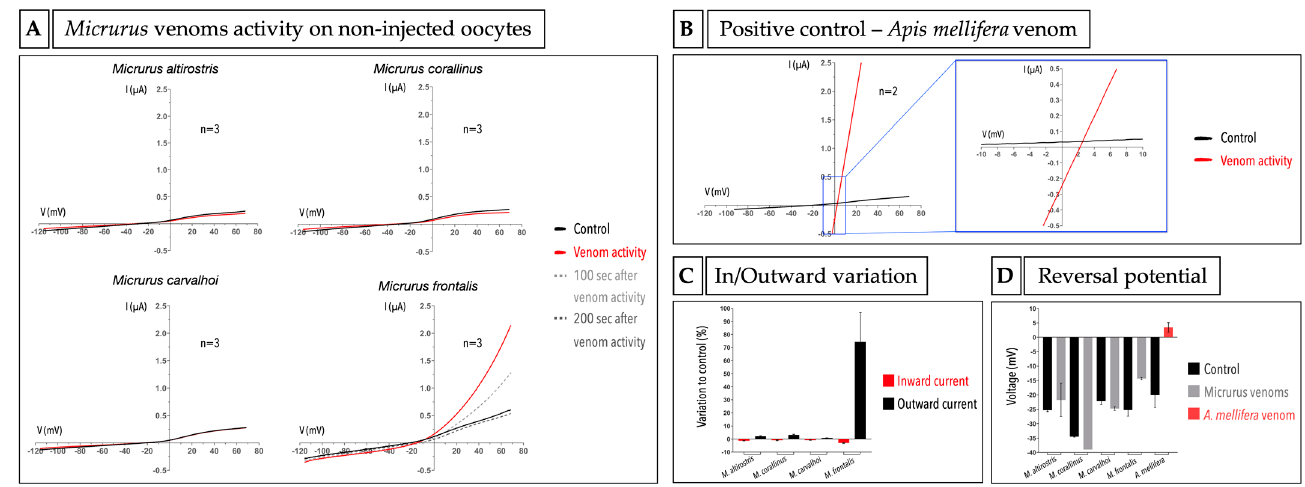
Figure 3. Cytotoxic evaluation of crude venoms on X. laevis non-injected oocytes. ( A ) Micrurus altirostris , Micrurus corallinus , Micrurus carvalhoi and Micrurus frontalis venom activity. ( B ) Positive control- Apis mellifera venom activity. The black lines show the control, and the red lines show the venom activity. In panel ( A ), the dotted dark gray and light gray lines show 100 s and 200 s of past time from the venom activity, respectively. The blue box shows a zoom of the graph on panel ( B ). The graphs show the trace of one experiment from a series of independent experiments. ( C ) Inward and outward current graph. ( D ) Reversal potential graph.